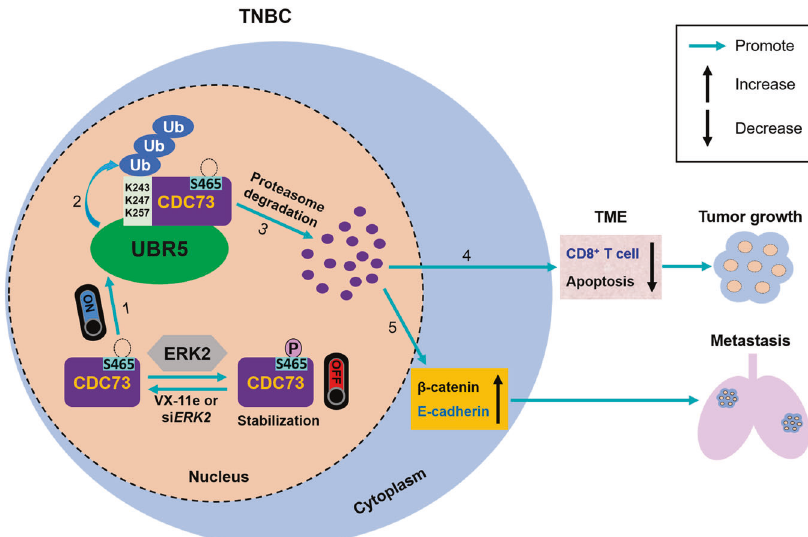
Fig. 8 The molecular switch role and mechanism of CDC73 for UBR5-drived TNBC tumor growth and metastasis. In TNBC cells, CDC73 is stabilized by ERK2-mediated phosphorylation at Ser 465 . UBR5 targets non-phosphorylated CDC73 (1) and ubiquitinates it at Lys 243 , Lys 247 and Lys 257 residues (2) for degradation by UPS (3). Degradation of CDC73 promotes UBR5 ’ s tumorigenic and immunoregulatory activities in TME (4), as well as tumor metastasis in a cell-intrinsic manner by regulating both mRNA and protein expression of β -catenin and E-cadherin